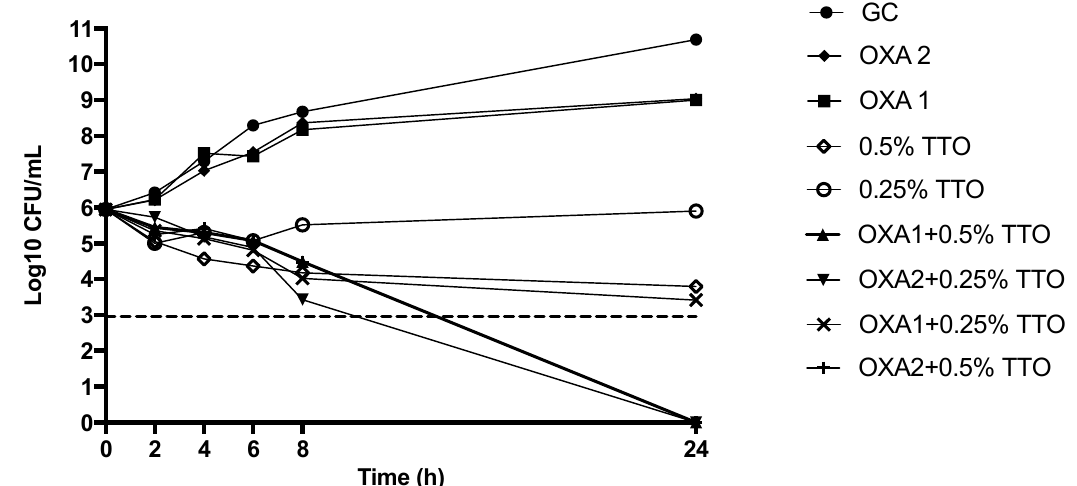
Figure 3. Activity of TTO ( v / v ) and OXA ( µ g/mL) at different concentrations against MRSA throughout killing study. GC: Growth Control; MRSA: Methicillin-resistant Staphylococcus aureus ; OXA: oxacillin. Dashed line represents bactericidal activity.